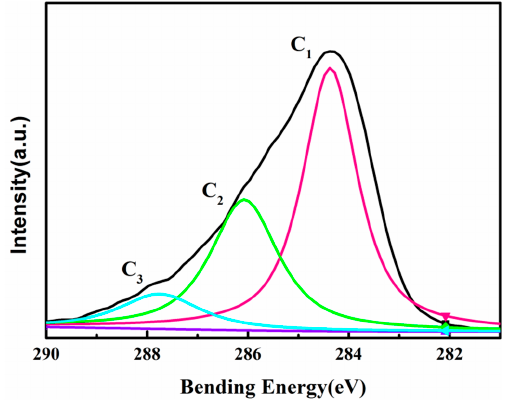
Figure 5. High-resolution C 1s maps of almond shells. Table 6. X-ray photoelectron spectroscopy (XPS) test results of almond shells C 1s.